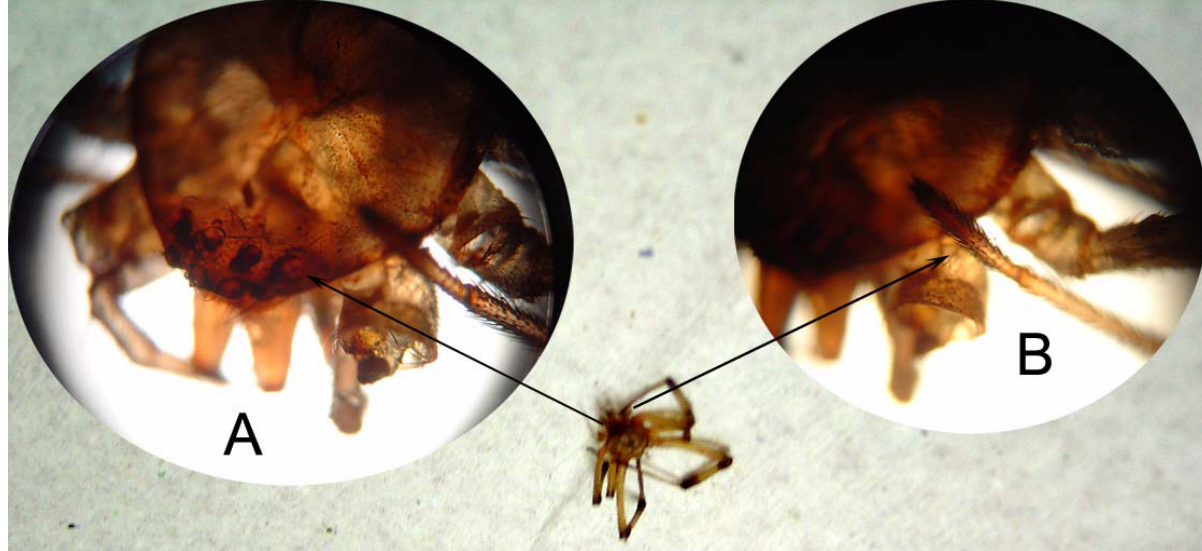
Figure 2. Latrodectus geometricus spider (brown widow) that provoked the accident. Identification through the spider eye arrangement 4:4 ( A ) and comblike bristles ( B